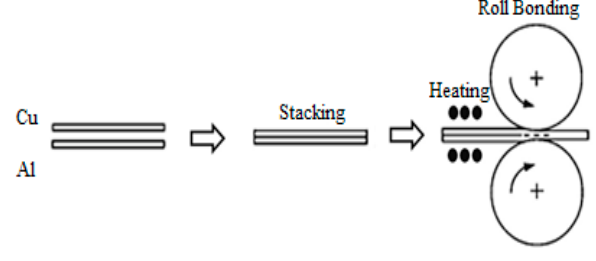
Figure 2. Schematic diagram of the Roll Bonding (RB) process.